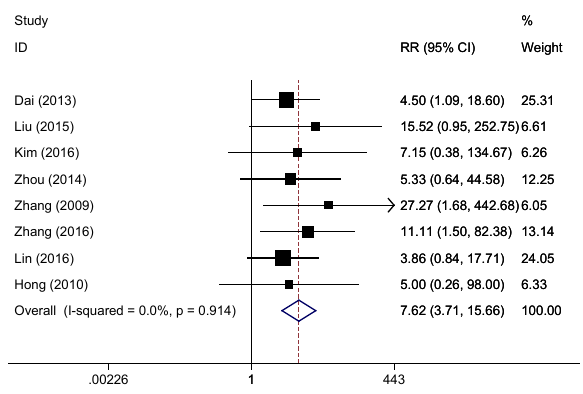
Figure 6: Forest of neutropenia of Pemetrexed versus Gefitinib as second-line treatment for advanced NSCLC.